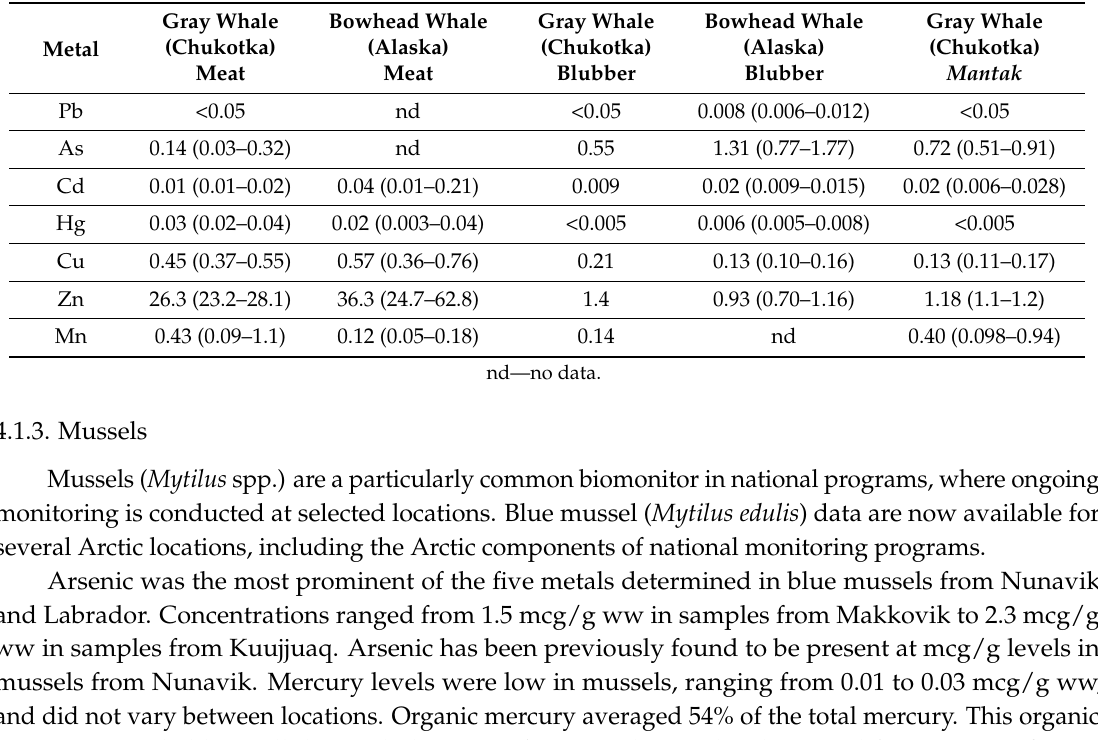
Table 6. Concentrations of selected metals in meat, blubber, and mantak samples of gray whale from Chukotka (present study) and bowhead whale from Alaska [18], mg/kg ww (ar mean and